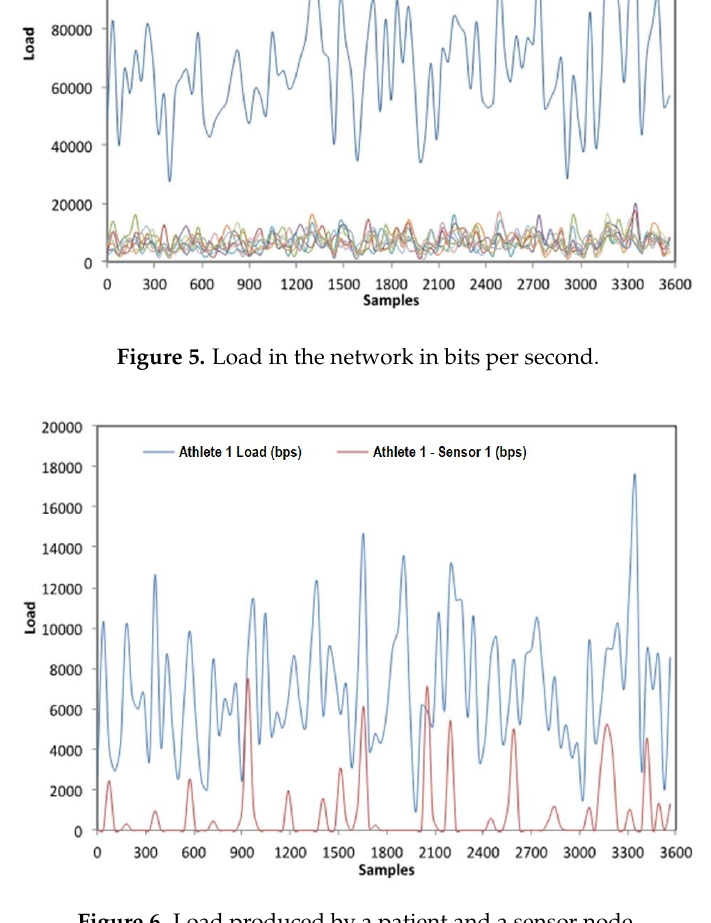
Figure 6. Load produced by a patient and a sensor node.